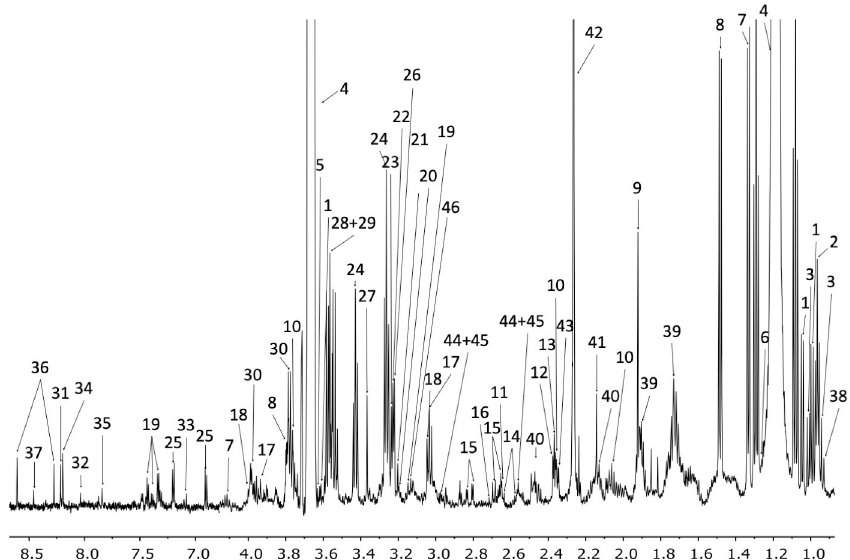
Fig 3. The assigned UUM 1 H-NMR spectrum of PBMCs. Metabolite assignments are indicated by the numbers 1. Valine, 2. Leucine, 3. Isoleucine, 4. Ethanol, 5. Threonine, 6. 3-Hydroxyisovalerate, 7. Lactate, 8. Alanine, 9.